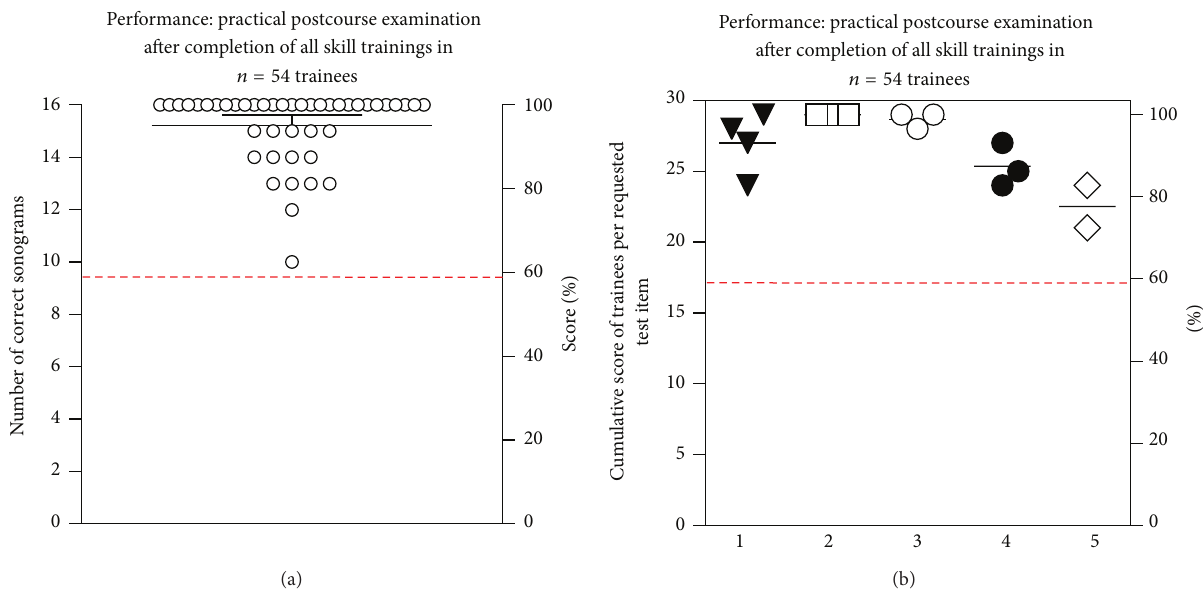
Figure 4: (a)-(b) Practical postcourse examinations after completion of all skill trainings (a) Every circle represents the sum of correct ultrasound examinations of specific sites by individual trainees, as assessed by practical postcourse examination (maximum count: 𝑛 = 16 ). (b) Each identical symbol represents a distinct learning objective (1: trachea, thyroid, central vessels, and isthmus, 2: chest wall, 3: pleura, lung, 4: diaphragm, solid organs, and 5: detection sequence of PLE or PTX). Data are arranged to visualize the cumulative scores of trainees per tested objective (maximum count: 𝑛 = 54 ). Dashed line indicates an arbitrary defined pass level of 60% correct